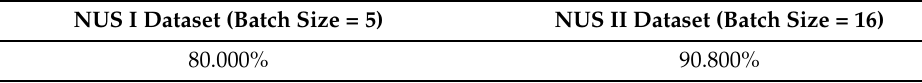
Table 12. CNN accuracies.